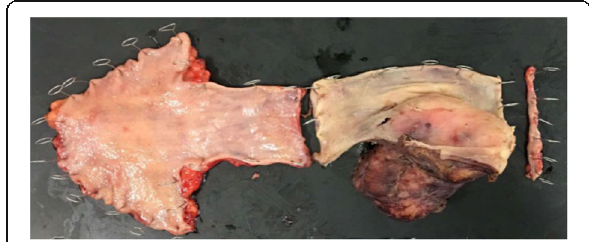
Fig. 5 Macroscopic appearance of the tumor. The resected tumor